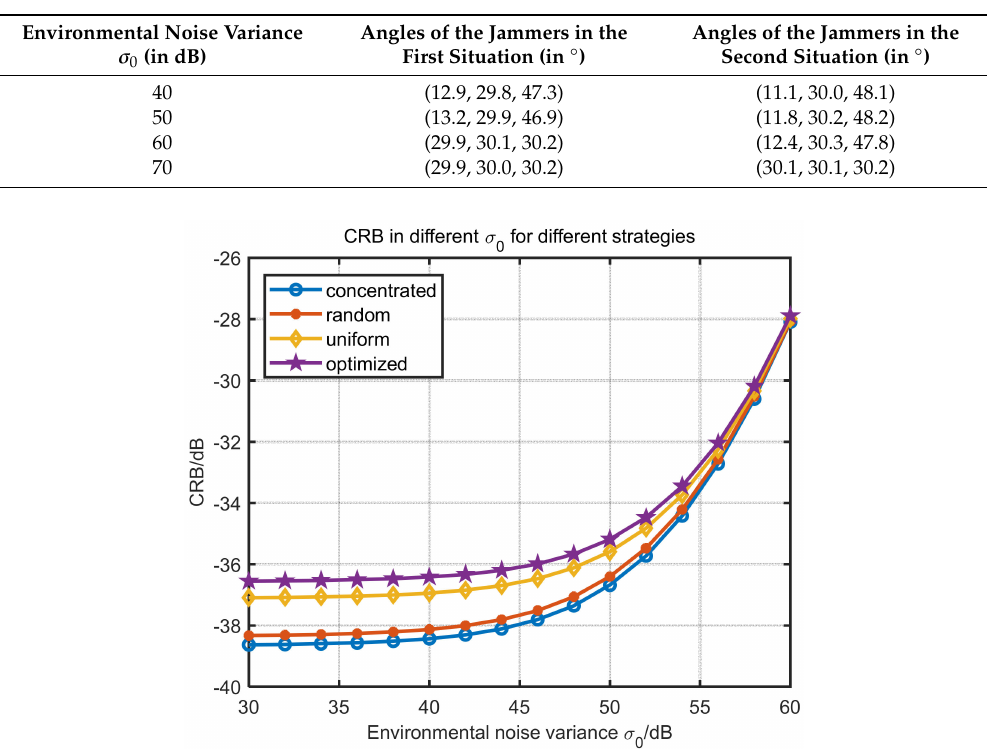
Table 5. Optimized angles of three jammers with respect to the three-array networks under environmental noise with di ff erent variances in a single-target scene.